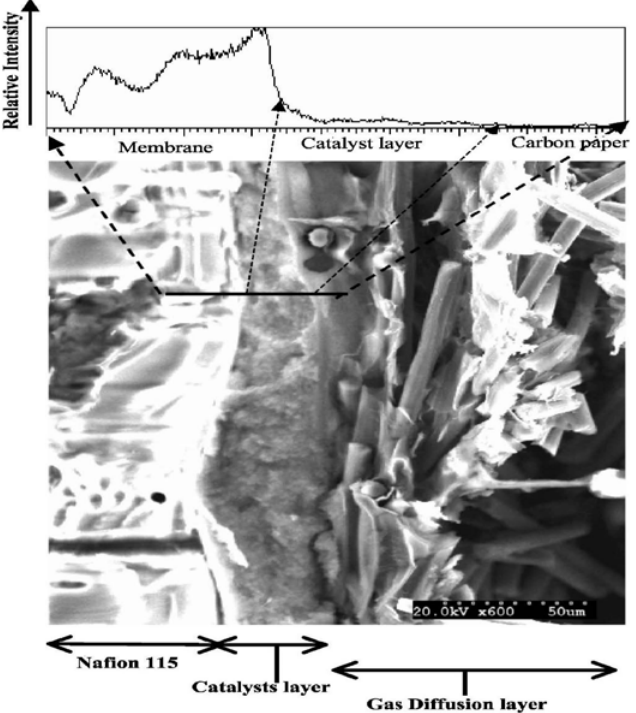
Figure 5. Scanning electron microscopy (SEM) micrograph of a cross-section of the membrane electrode assembly, along with a profile of elemental fluorine across the layers. Reprinted with permission from [33]. Copyright 2012, The Electrochemical Society.